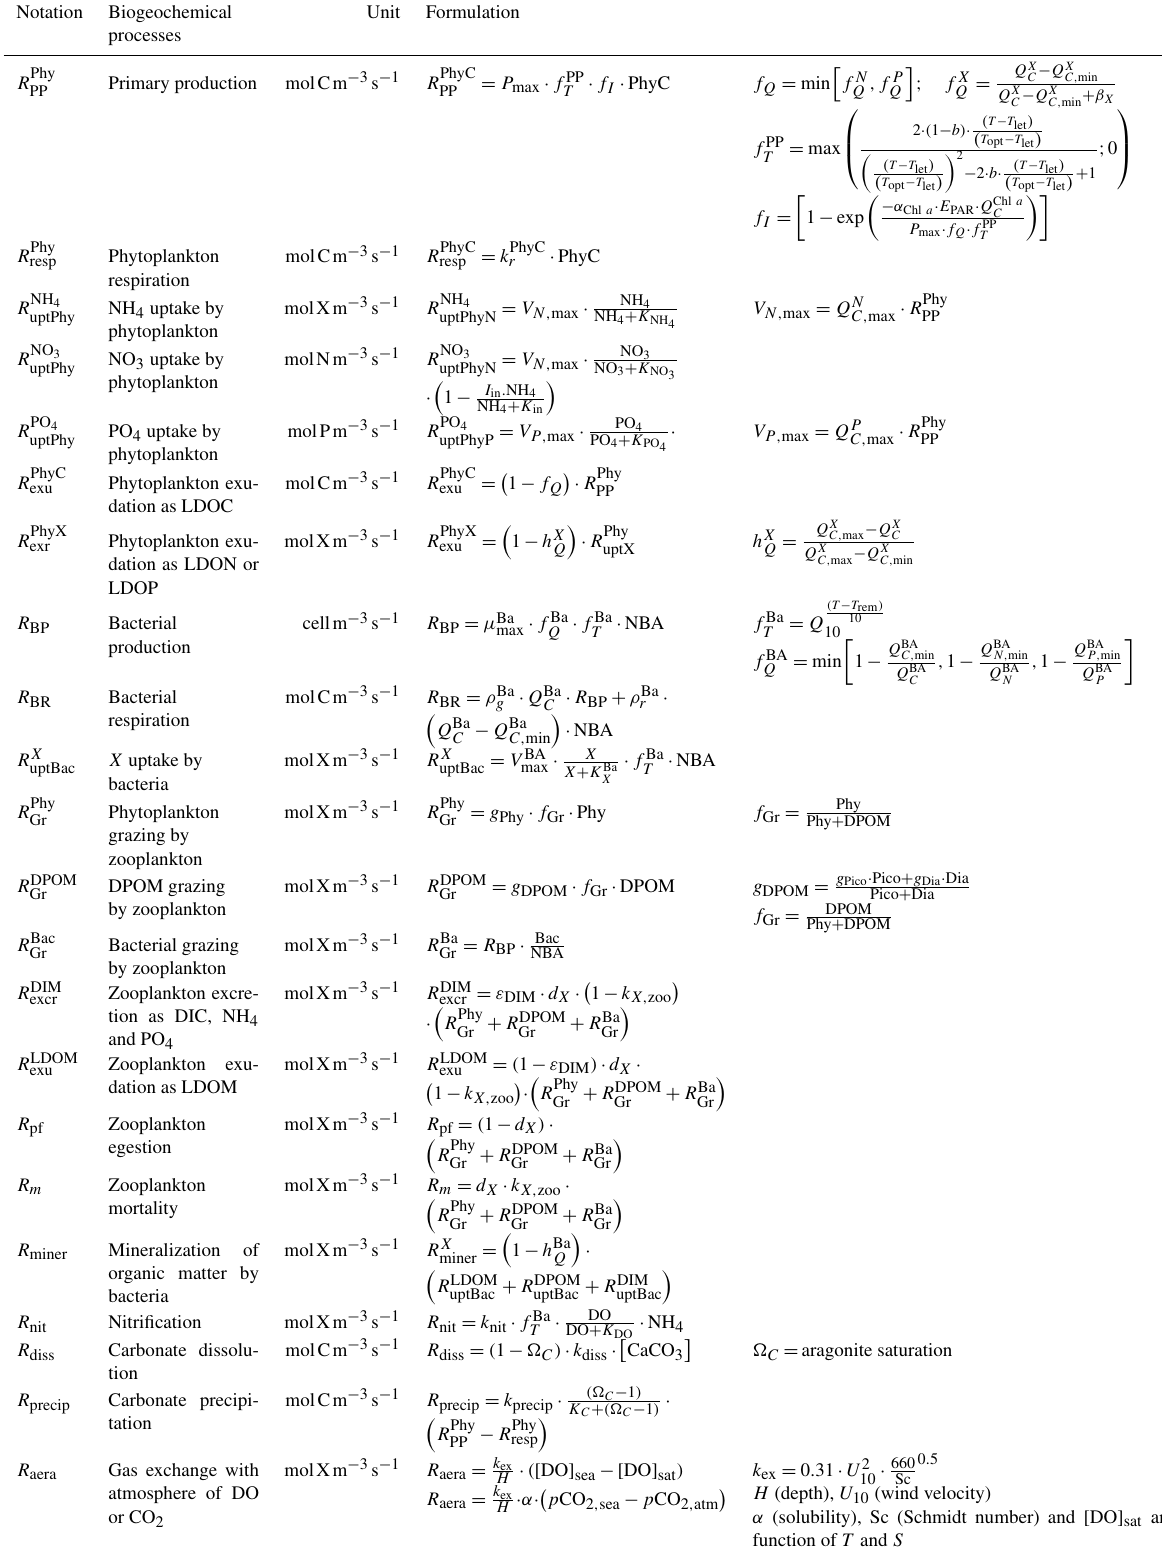
Table B3. Biogeochemical processes simulated by the Eco3M-CarbOx model.